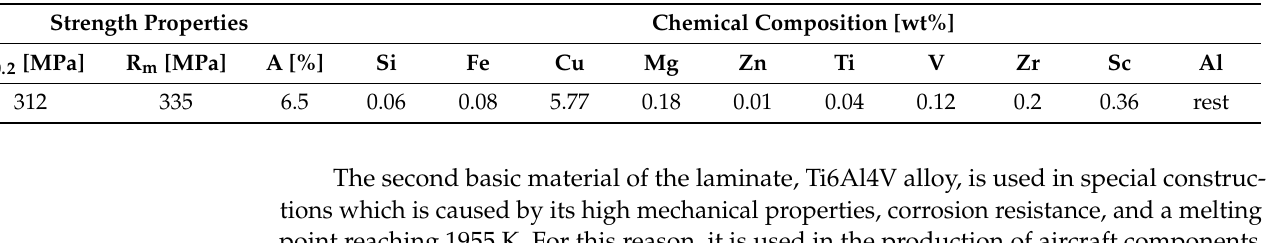
Table 1. Strength properties and chemical composition of the AA2519 alloy.